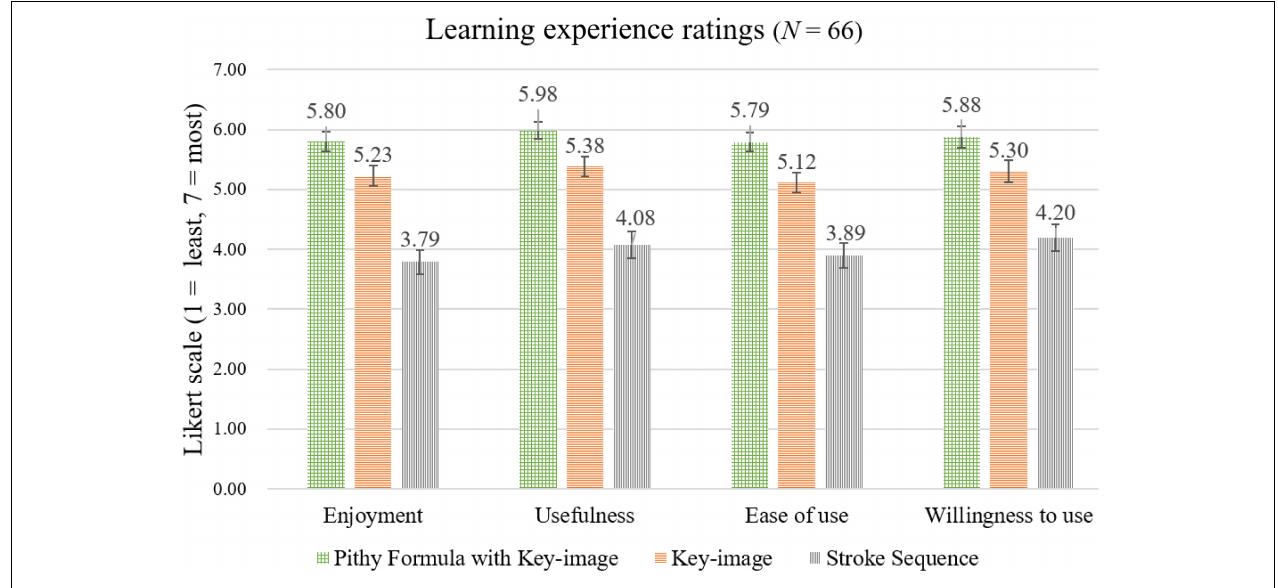
FIGURE 3 | The participants’ mean ratings on enjoyment, usefulness, ease of use, and willingness to use for each learning